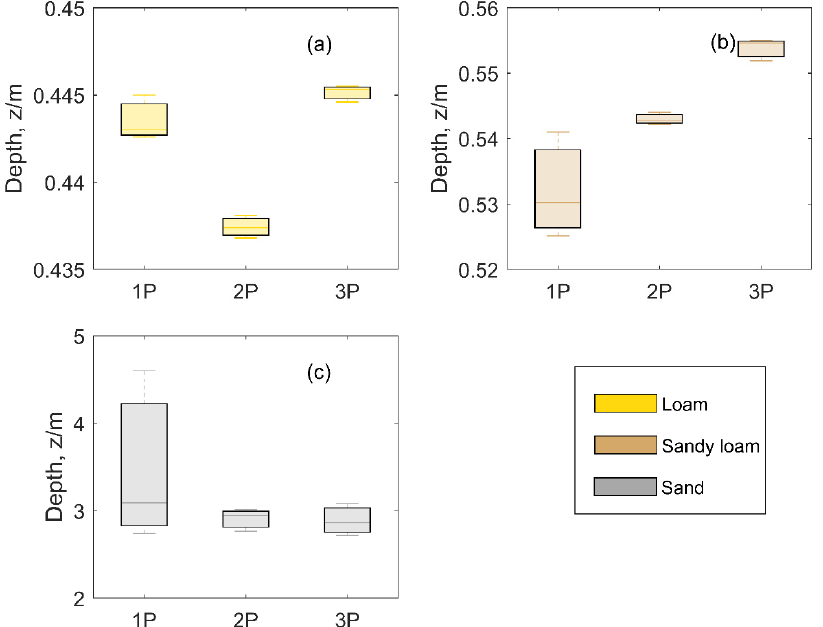
Figure 4. Maximum depth in the medium that can be affected by the pressure difference of three different soils: ( a ) loam; ( b ) sandy loam; ( c ) sand, where 1P represents 1 first level (100 mL) of pres- sure difference, 2P, 3P, and so on.